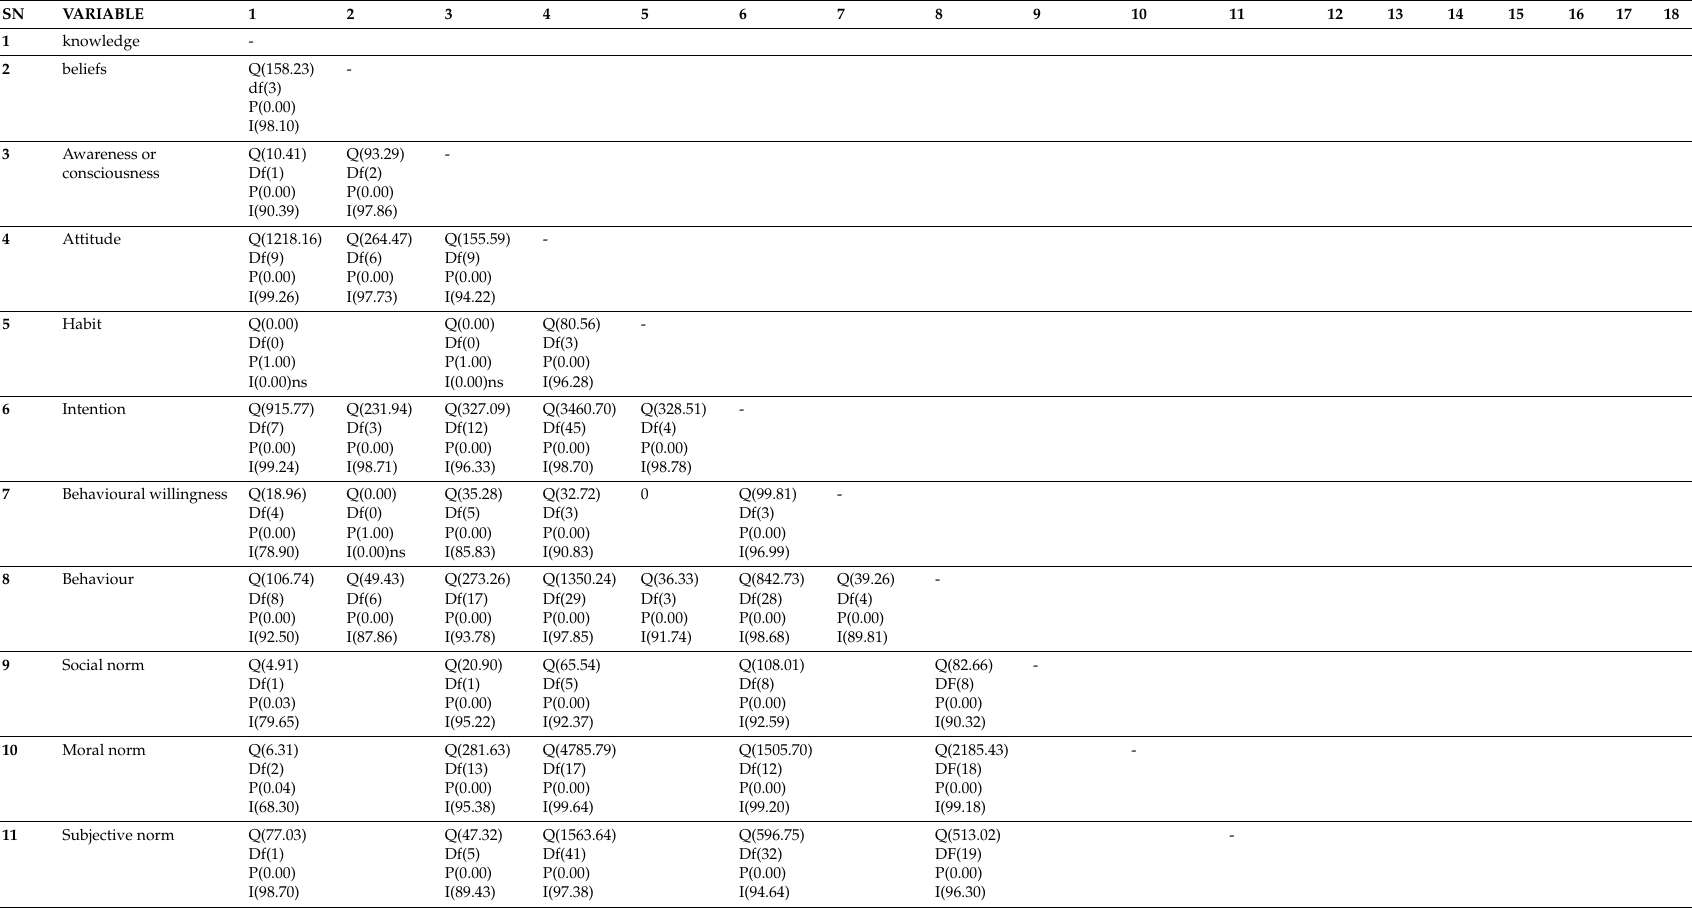
Table A3. Results of test of